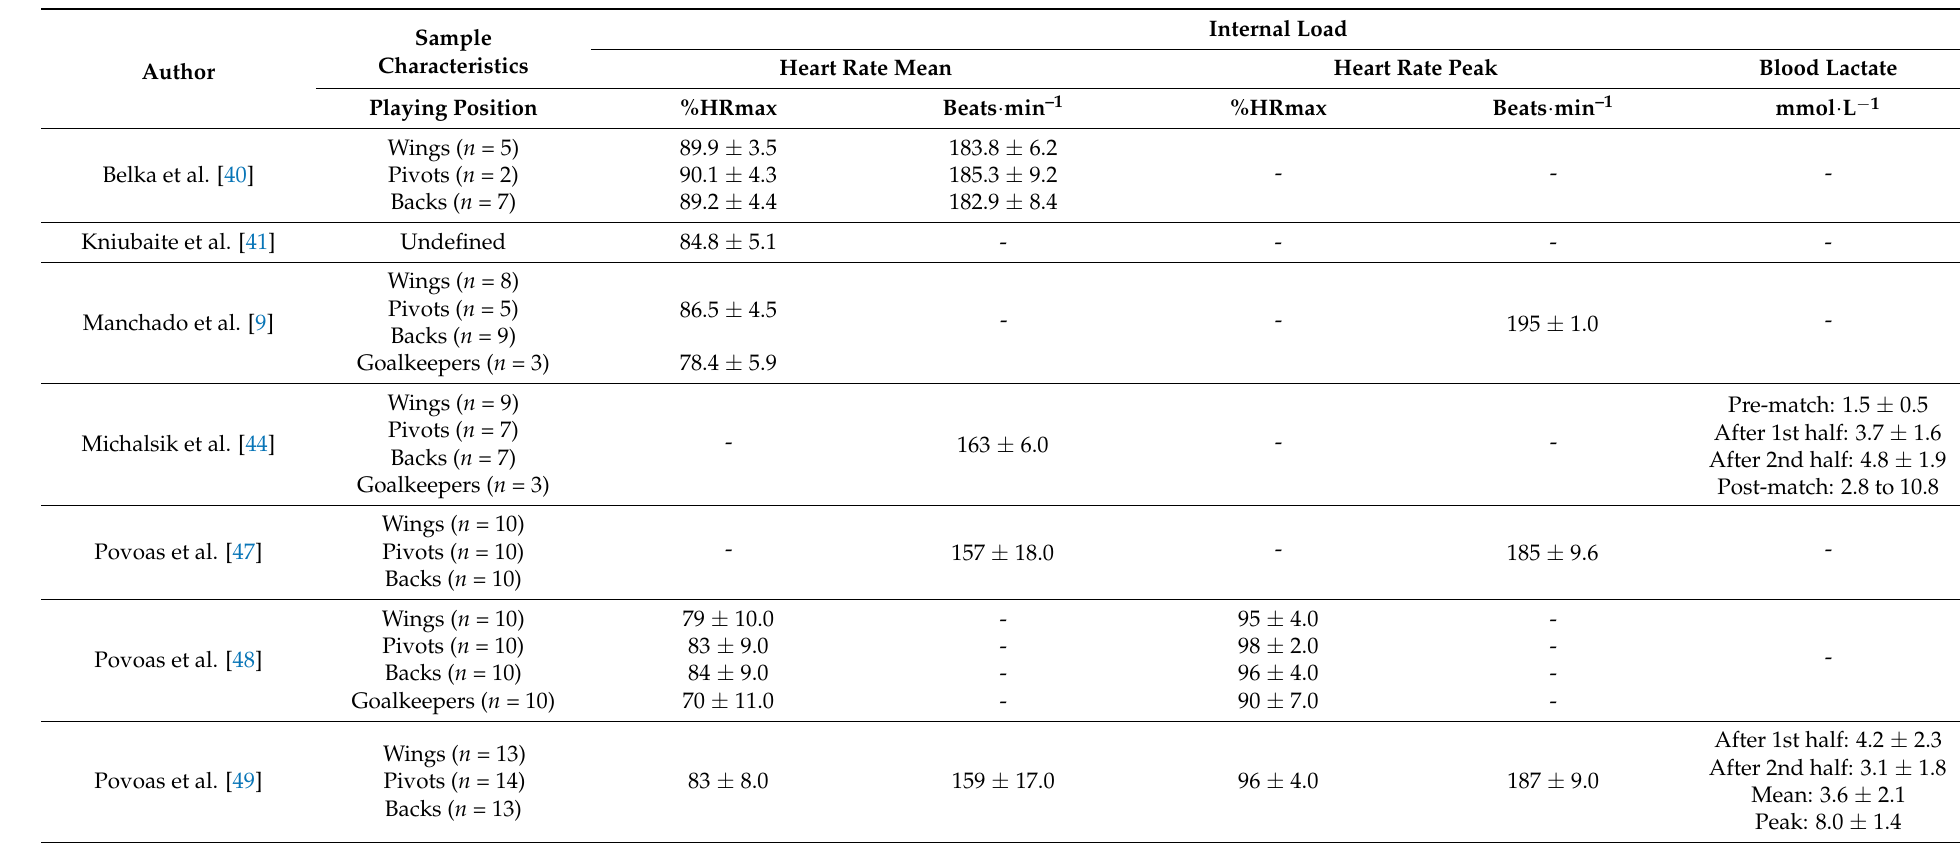
Table 4. Internal load